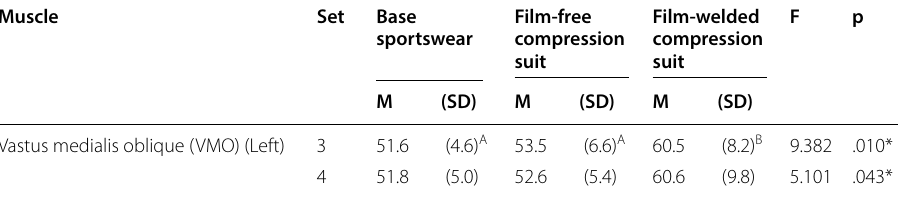
Table 2 MDF for muscles at each exercise set (data presented only if there were significant differences by type of clothing) (unit: Hz)